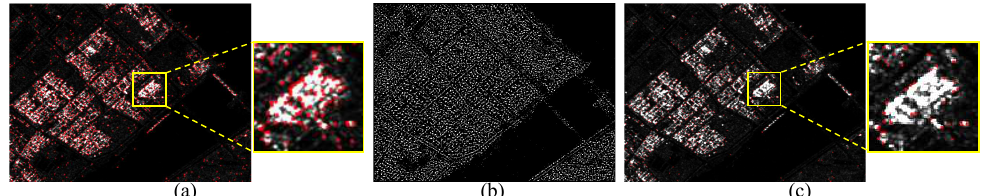
Figure 5. Visualization of keypoint detection results. ( a ) Proposal keypoints obtained by the PC detector. ( b ) Texture features obtained by RI-LBP. ( c ) Keypoints obtained by the TCPC